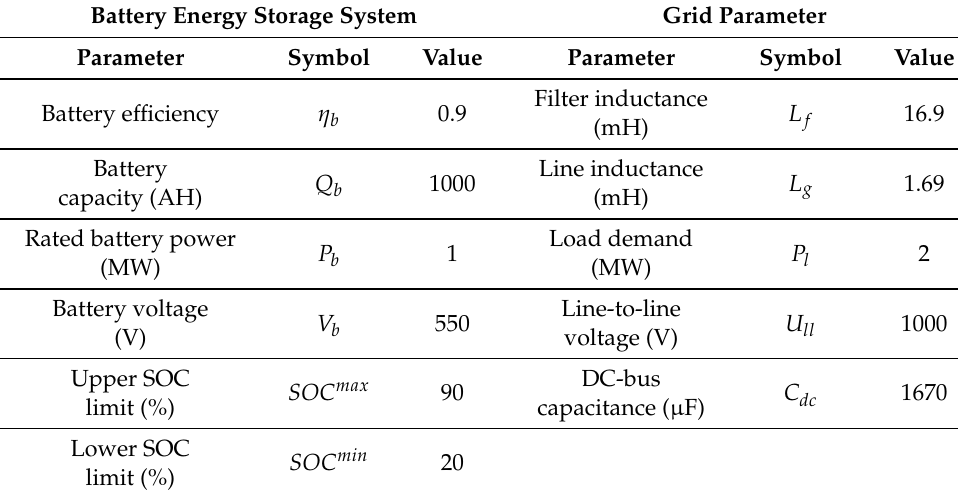
Table 2. Grid and energy storage parameters [42].